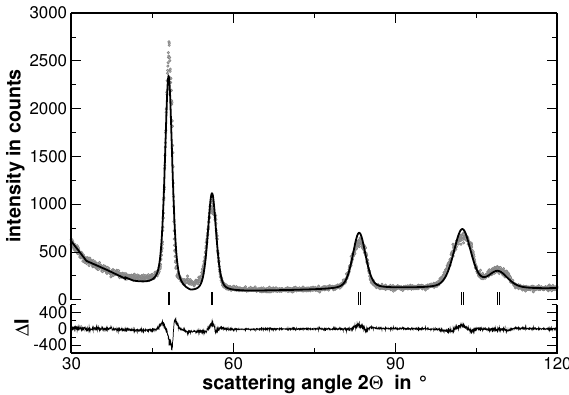
Figure 4. Experimental (points) and calculated (solid line) XRD patterns as well as their difference ∆ I (lower part) of AuCuNiPt in a highly segregated